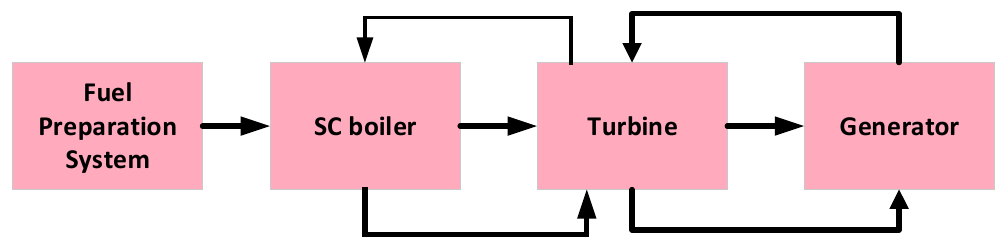
Figure 5. The boiler-turbine-generator physical interactions.